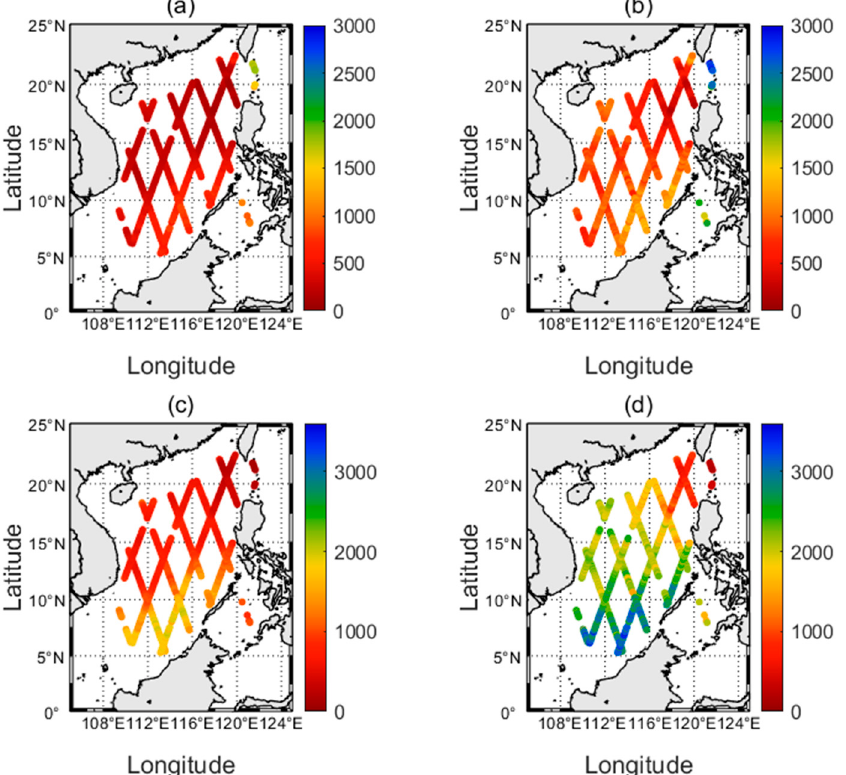
Figure 3. Spatial distribution of SNR of M 2 and O 1 constituents: ( a ) SNR of M 2 constituent before correction; ( b ) SNR of M 2 constituent after correction; ( c ) SNR of O 1 constituent before correction; ( d ) SNR of O 1 constituent after correction.